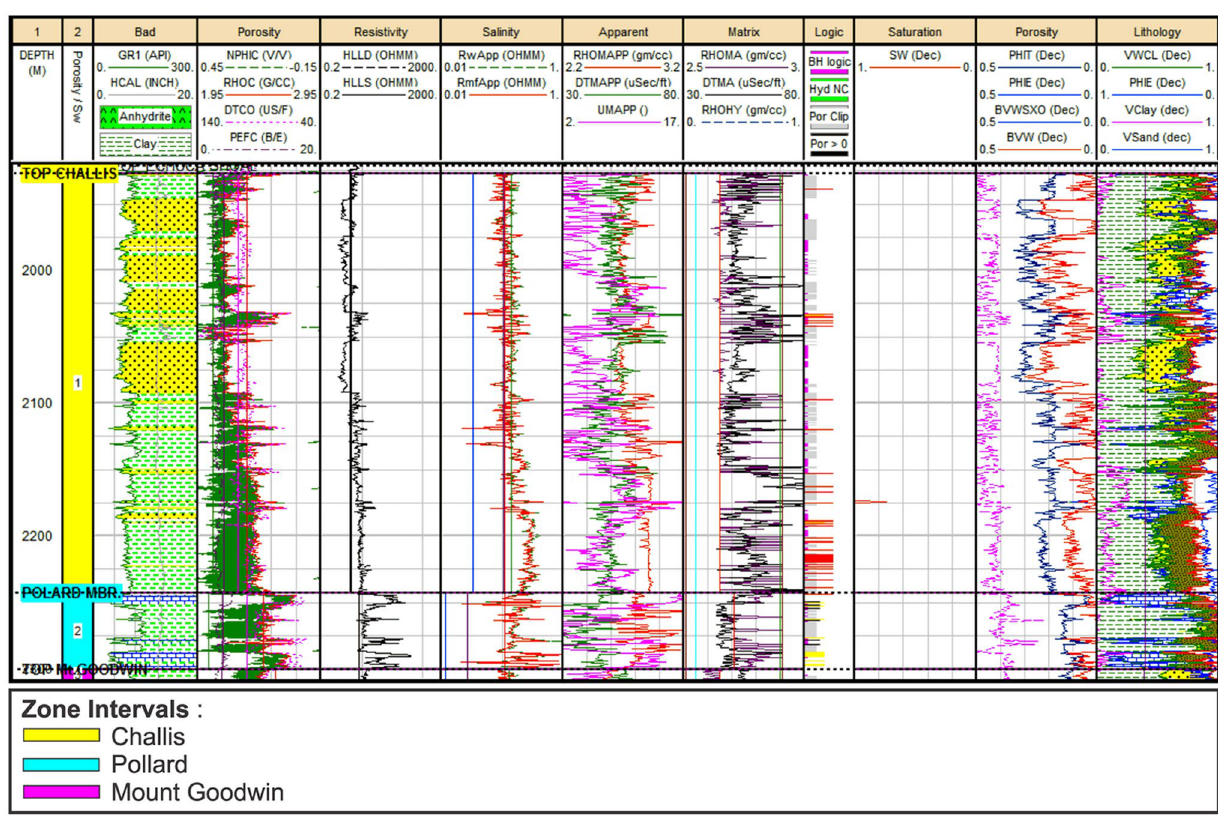
Fig. 4 Petrophysical analysis of Carnian–Ladinian Challis interval (yellow zone) of M-1 well indicates good porosity of reservoirs Fig. 5 Interpretation of north- west-southeast seismic lines in the study area revealed tilted fault blocks that are potential